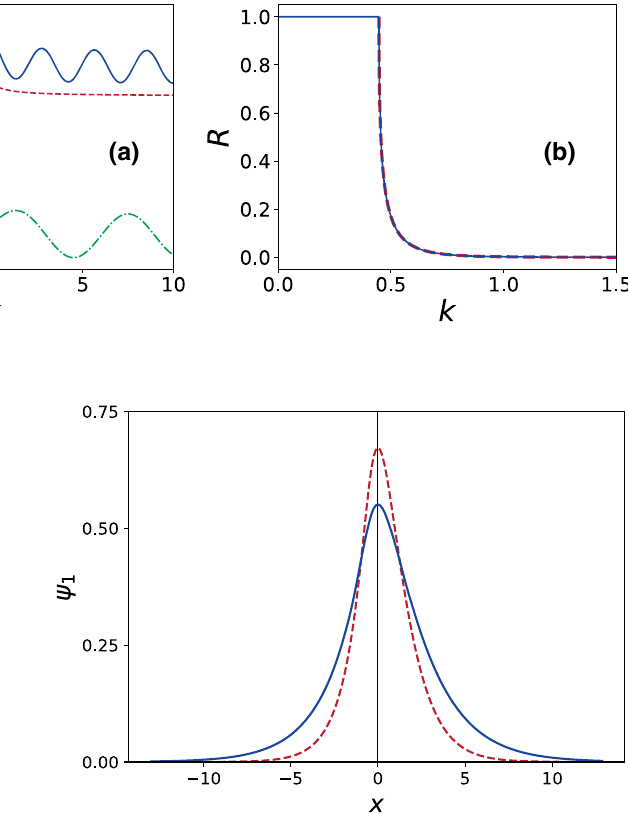
Fig. 6 Fermionic zero mode for g = 0 . 5 (solid curve in blue) and g = 0 . 9 (dashed curve in